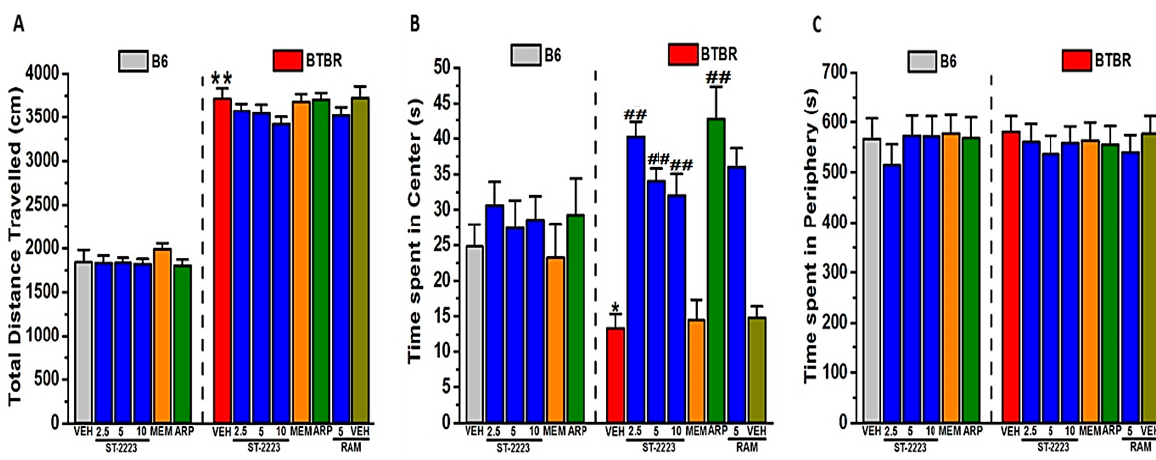
Figure 5. ST-2223 treatment did not affect locomotor activity in BTBR mice. Locomotor activity was assessed in B6 and BTBR mice. Each mouse received an i.p. injection of vehicle, ST-2223 (2.5, 5.0, or 10 mg/kg, i.p.), MEM (5 mg/kg, i.p.), or ARP (1 mg/kg, i.p.) 30–45 min prior to locomotion was measured. BTBR mice travelled significantly greater distances compared to those of B6 mice ( A ). Vehicle, ST-2223, MEM, or ARP treatment did not affect locomotor activity in B6 or BTBR mice ( A and C ). BTBR mice spent significantly less time in the center of the arena compared to that of B6 mice ( B ). ST-2223 (2.5, 5 and 10 mg/kg, i.p.) and ARP (1 mg/kg, i.p.) significantly mitigated the decreased amount of time spent by BTBR mice in the center. MEM (5 mg/kg, i.p.) failed to alter the decreased amount of time BTBR mice spent in the center. Data are expressed as the mean ± SEM ( n = 5). * p < 0.05 vs. vehicle-treated B6 mice. ** p < 0.01 vs. vehicle-treated B6 mice. ## p < 0.01 vs. vehicle-treated BTBR mice.